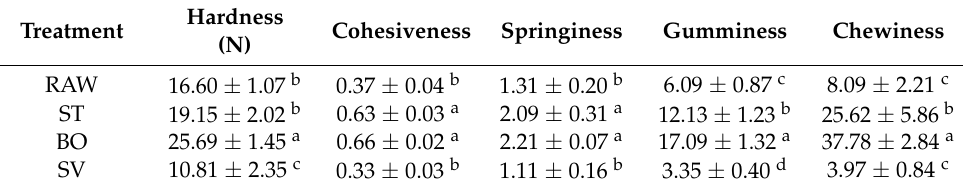
Table 3. Texture analysis results of squid ( Symplectoteuthis oualaniensis ) mantle muscle samples at different cooking